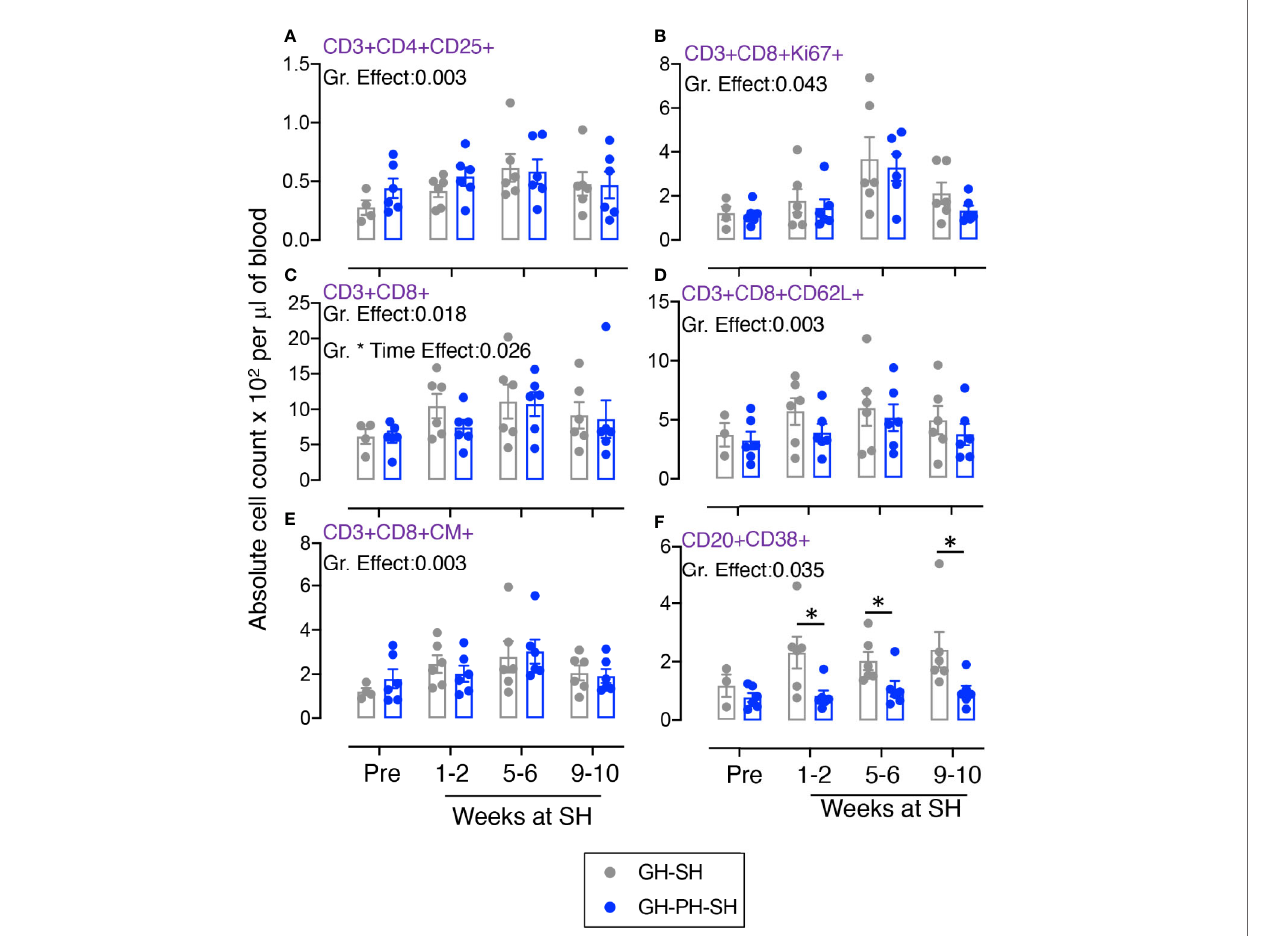
FIGURE 6 | Absolute count of peripheral blood T and B cells and its subpopulation were shown for GH-SH and GH-PH-SH groups. A signi fi cant difference in regulatory CD4+CD25+ (A) , proliferating CD8+Ki67+ (B) , total CD8+ (C) , traf fi cking CD8+CD62L+ (D) , central memory (CM) CD8+CD28+CD95+ (E) , and activating CD20+CD38+ (F) cells was detected between groups across house treatment time points. A signi fi cant difference in total CD8+ T cells (C) was also detected between GH-SH and GH-PH-SH groups when time and group interaction studied (p = 0.026). The X axis denotes pre- and post-separation housing time points and the Y axis denotes absolute counts. Individual values from each animal are shown as colored circles with bars showing mean ± standard error for each group. Asterisks denote statistical signi fi cant differences (p < 0.05) between groups for the speci fi ed time